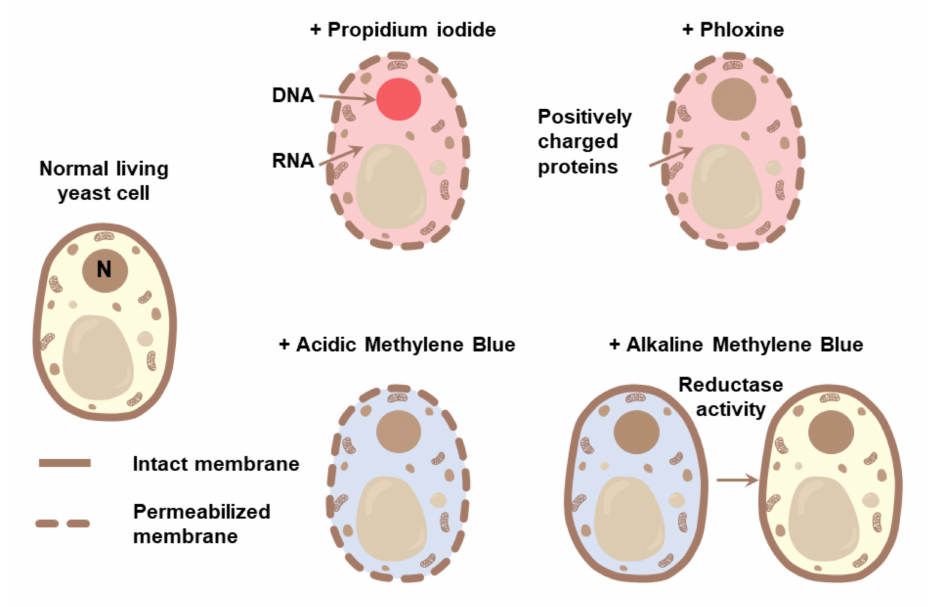
Figure 3. Schematic of the action of the methylene blue and phloxine B membrane permeability